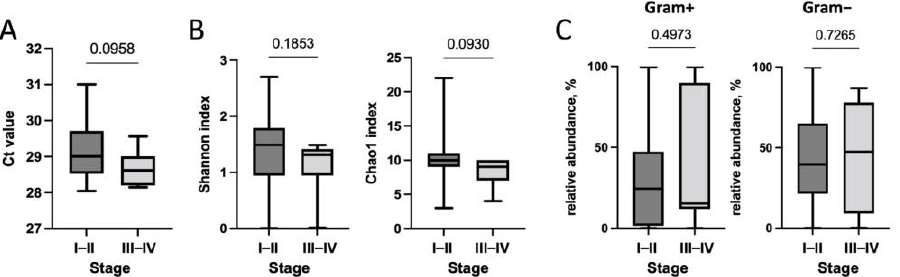
Figure 4. Analysis of the association of the qualitative and quantitative composition of the microbiome (( A ) — total bacterial load, ( B ) — Shannon and Chao1 indexes) with the RCC stage. ( C ) — association of relative content of Gram-positive and Gram-negative bacteria with the RCC stage. p -values are indicated above the lines.